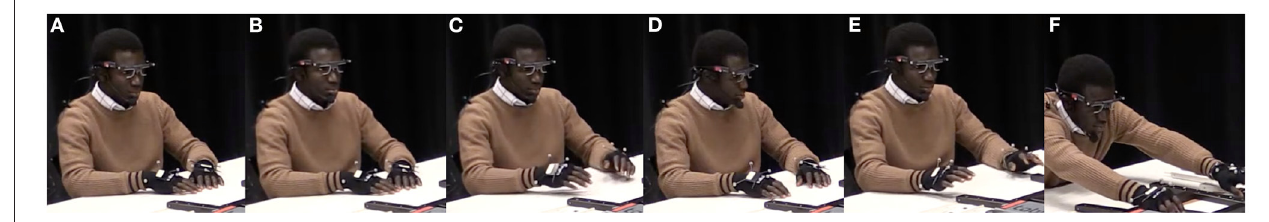
FIGURE 1 | An illustration of the recurrent listener signals (A–F) to fragmented utterances (see dialogue sample